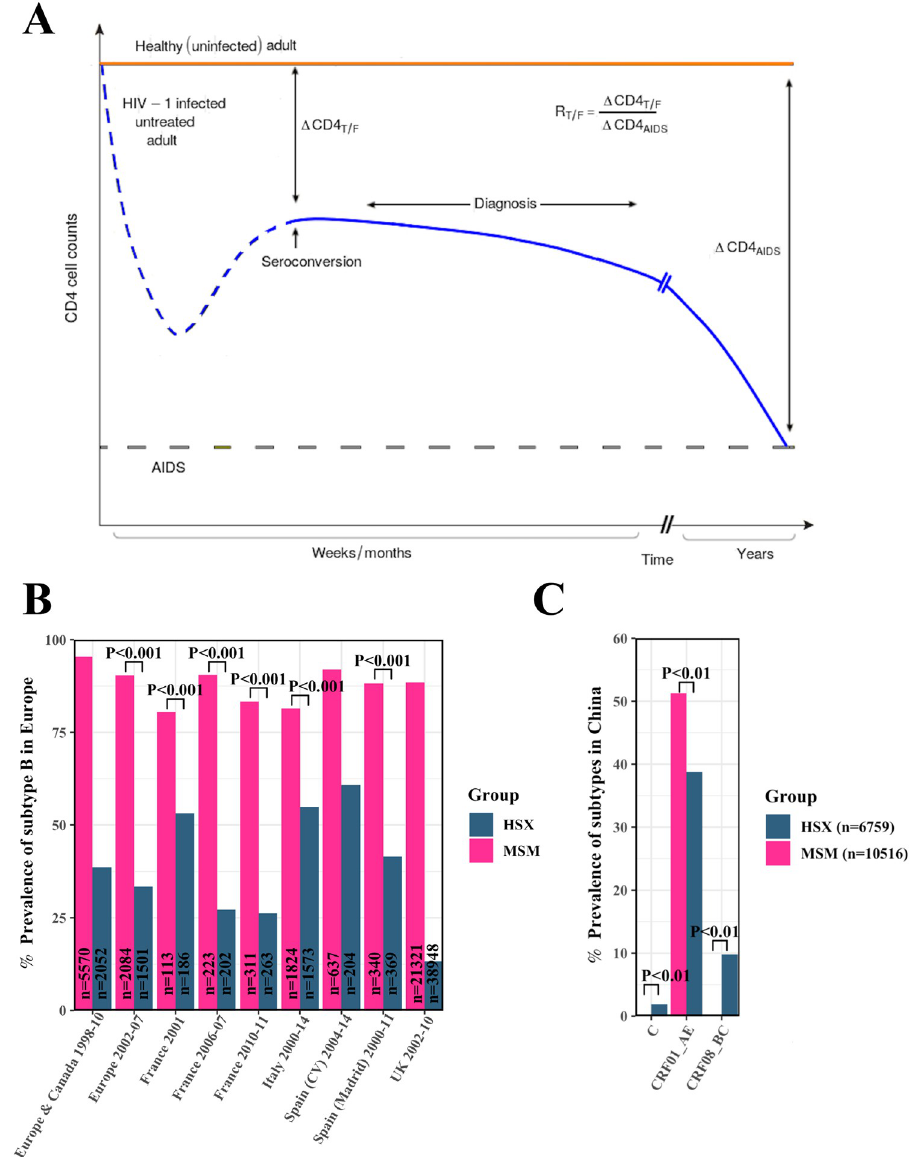
Fig 1. Marker and risk groups for assessing selection bias at transmission. (A) Schematic of typical CD4 count changes post HIV-1 infection (blue), before (dashed) and after (solid) diagnosis/seroconversion. The reduction at diagnosis/seroconversion relative to uninfected individuals (orange) and that associated with AIDS (grey dashed line) yields R T / F , the reduction attributable to the T/F virus. (B-C) HIV-1 subtype prevalence in MSM and HET populations. Prevalence of (B) subtype B in different regions in Europe and Canada and (C) all the subtypes in China. (CV denotes Communidad Valenciana.) The sample sizes ( n ) along with the time periods of the surveys are indicated. P values are listed where available from the original sources (see S1 and S2